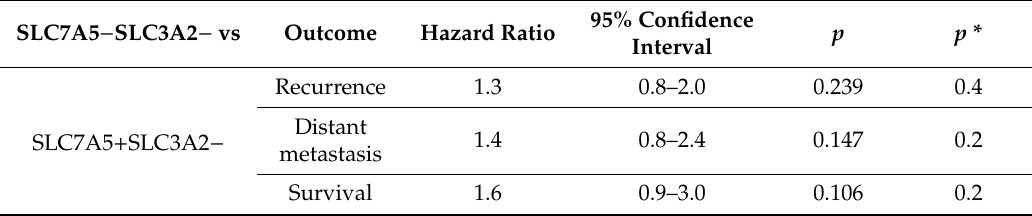
Figure 2. Kaplan–Meierof SLC7A5 / SLC3A2mRNA co-expressionandpatientoutcomeinER +/ HER2 − breast cancer using the METABRIC cohort: ( A ) recurrence, ( B ) distant metastasis and ( C ) breast-cancer-specific survival. Kaplan–Meier of SLC7A5 / SLC3A2 protein co-expression and patient outcome in ER +/ HER2 − breast cancer: ( D ) recurrence, ( E ) distant metastasis and ( F ) breast-cancer-specific survival. Table 2. Univariate analysis of associations between SLC7A5 / SLC3A2 co-expression in ER +/ HER2 − breast cancer of the Nottingham